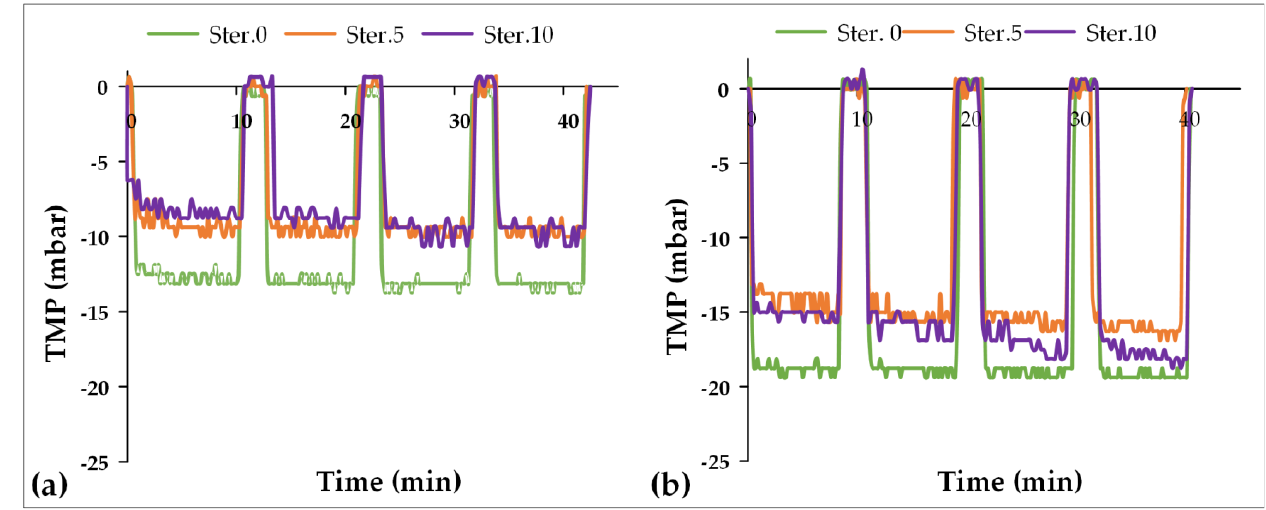
Figure 5. Temporal variation of TMP in the filtration tests performed using Yarrowia lipolytica MUCL 28849 fermentation broth for the pristine membrane and the same membrane after the 5th and the 10th sterilization cycles: ( a ) filtration test at 10 LMH flux; ( b ) filtration test at 15 LMH flux. SEM images from the pristine membrane, the clean membrane after the 10th sterili-